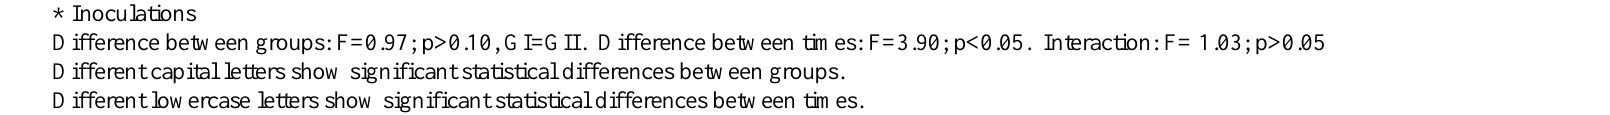
Table 4. Means and standard deviation of lymphocyte count (cells/ µ L) in sheep (n=12) inoculated at days zero, 30, and 60 with natural (NV) and Cobalt - irradiated (IrV) crotalic venom. 60